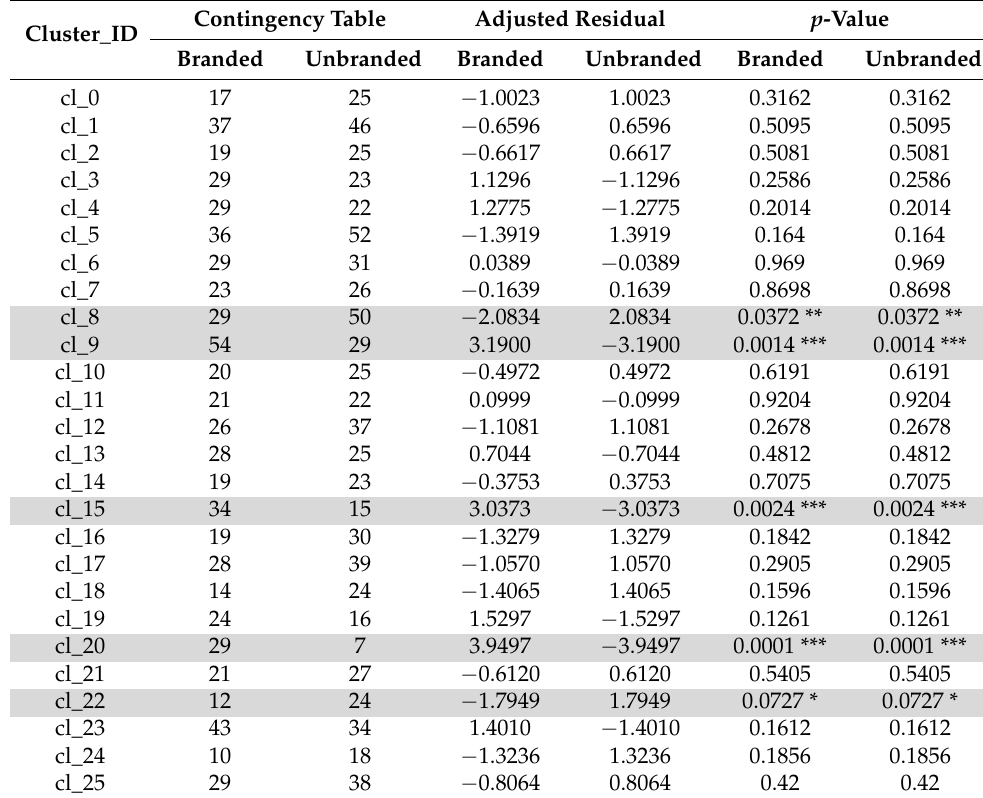
Table 5. Descriptive statistics (after feature engineering).